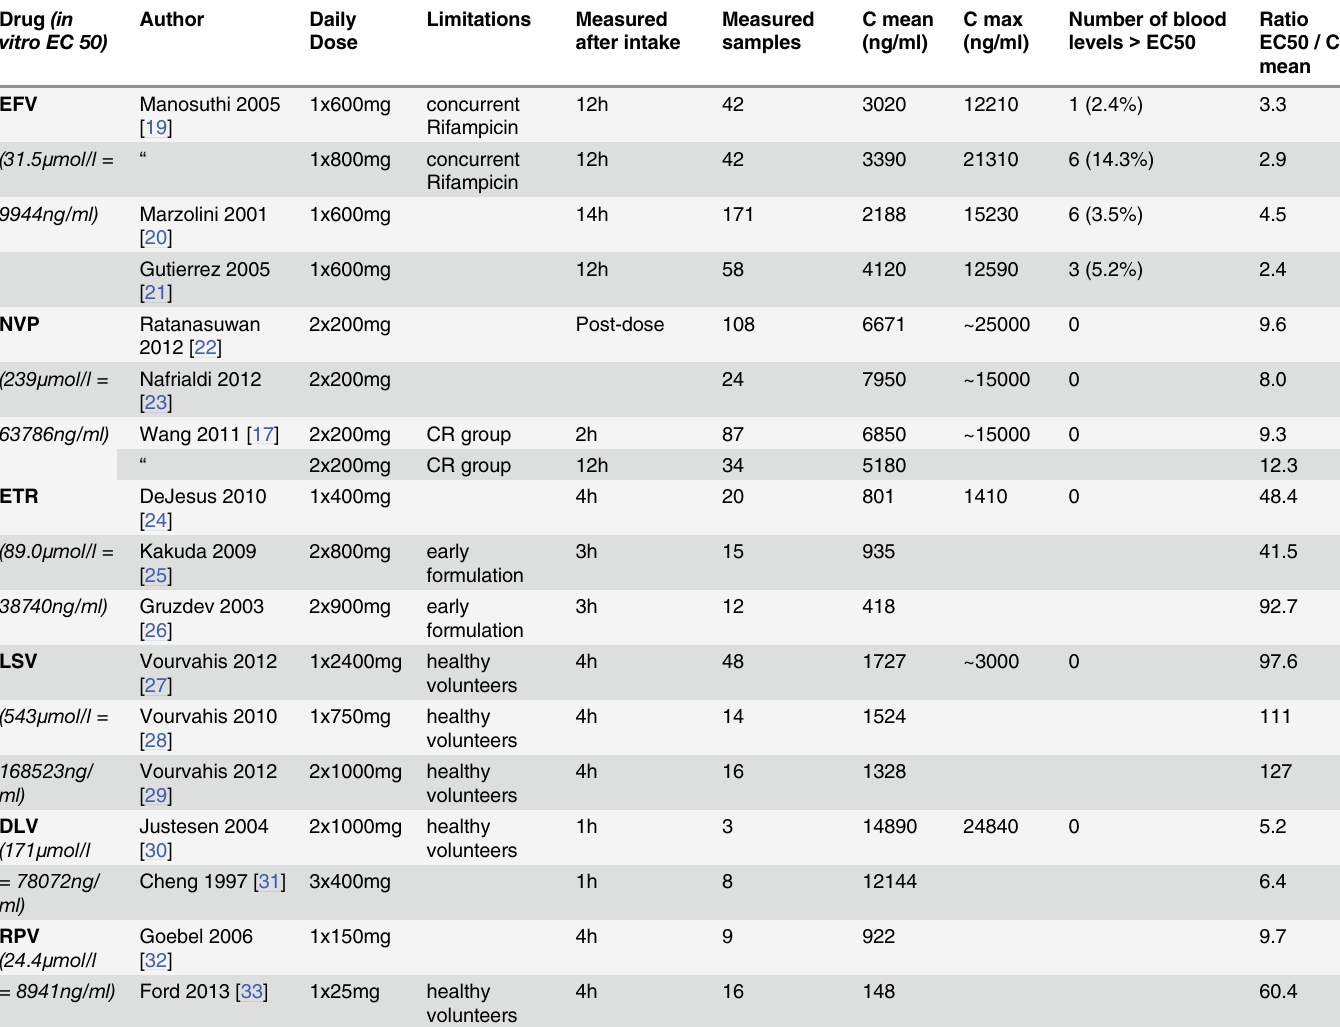
Table 1. Blood levels of various